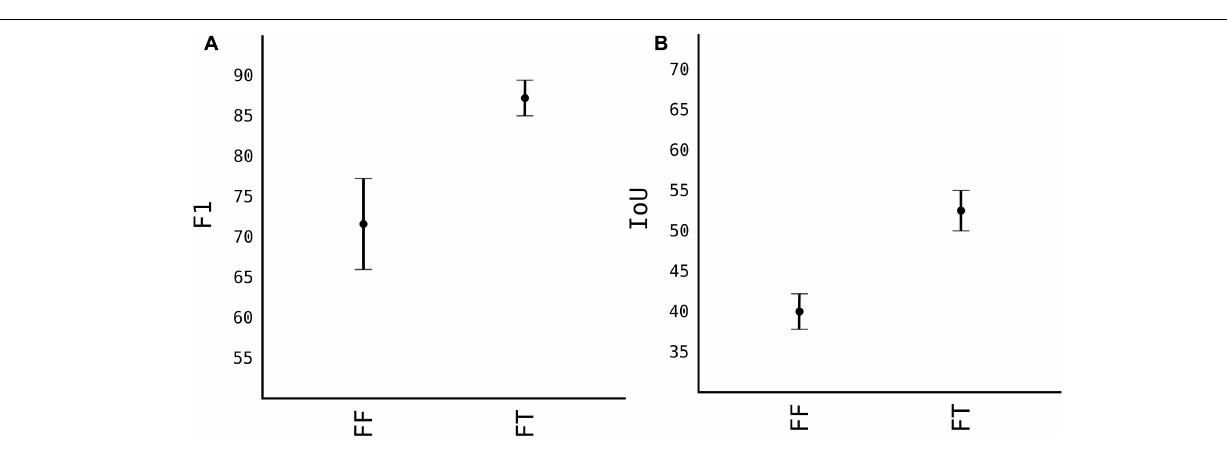
FIGURE 8 | Transfer learning from M3 + AS to pear images. (A) F1 accuracy score. (B) IoU accuracy